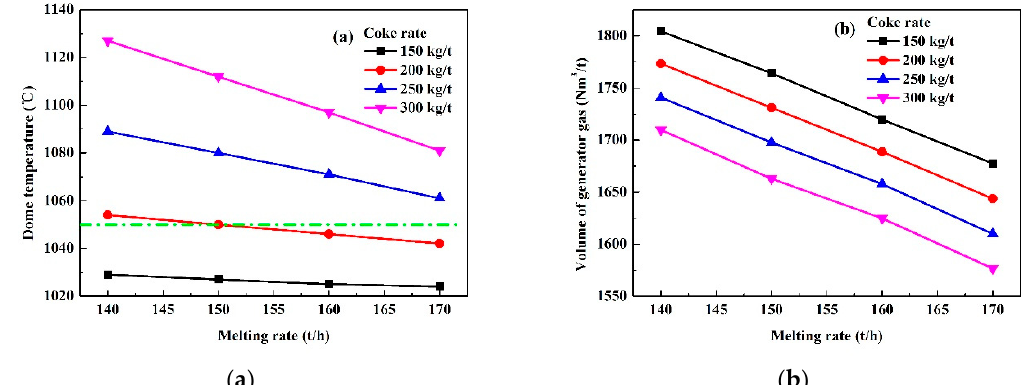
Figure 5. Effect of melting rate on ( a ) dome temperature and ( b ) volume of generator gas under different coke rates.